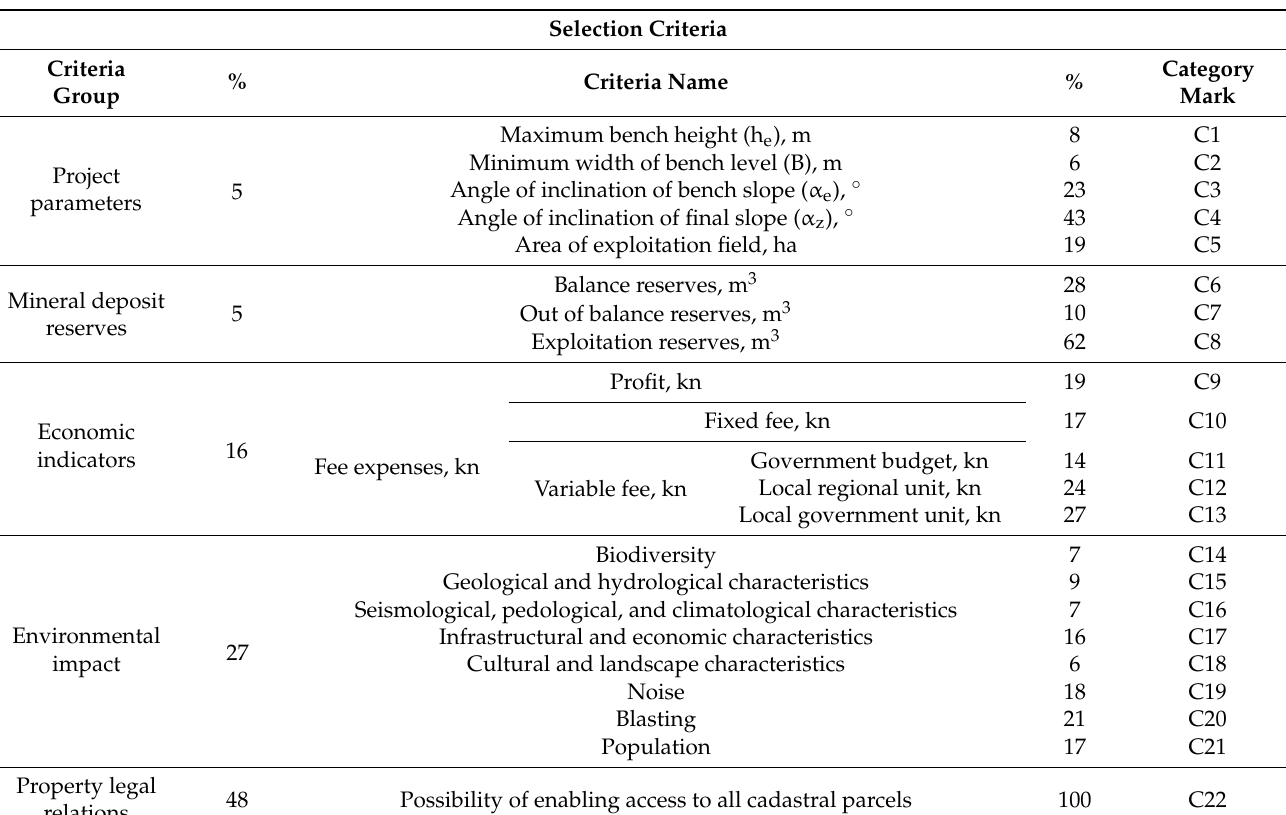
Table 7. Criteria and sub-criteria for the selection of the optimal model.